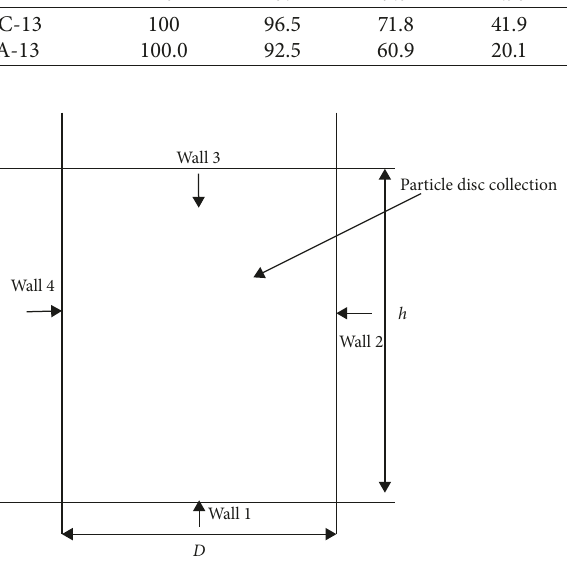
Figure 1: Digital mold and loading